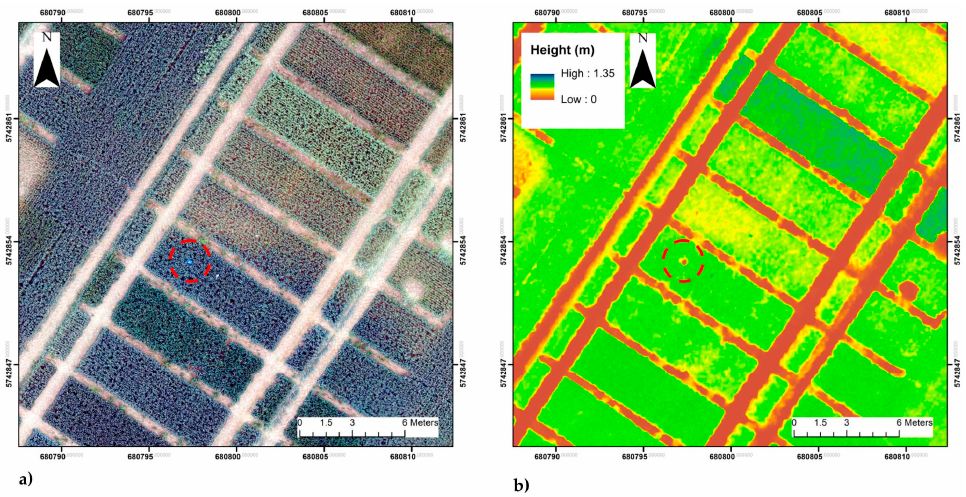
Figure 14. Side-by-side comparison of different cultivar plots in the N4 Treatment highlight the within-plot variability mapping achieved through the UAV based SfM technique. A hole (red circle) in the one of the plots is hard to make out in the orthomosaic ( a ) whilst being clearly visible in the nDSM ( b ). Data captured on 17 June 2015 and coordinates are displayed in WGS 1984 Coordinate System.